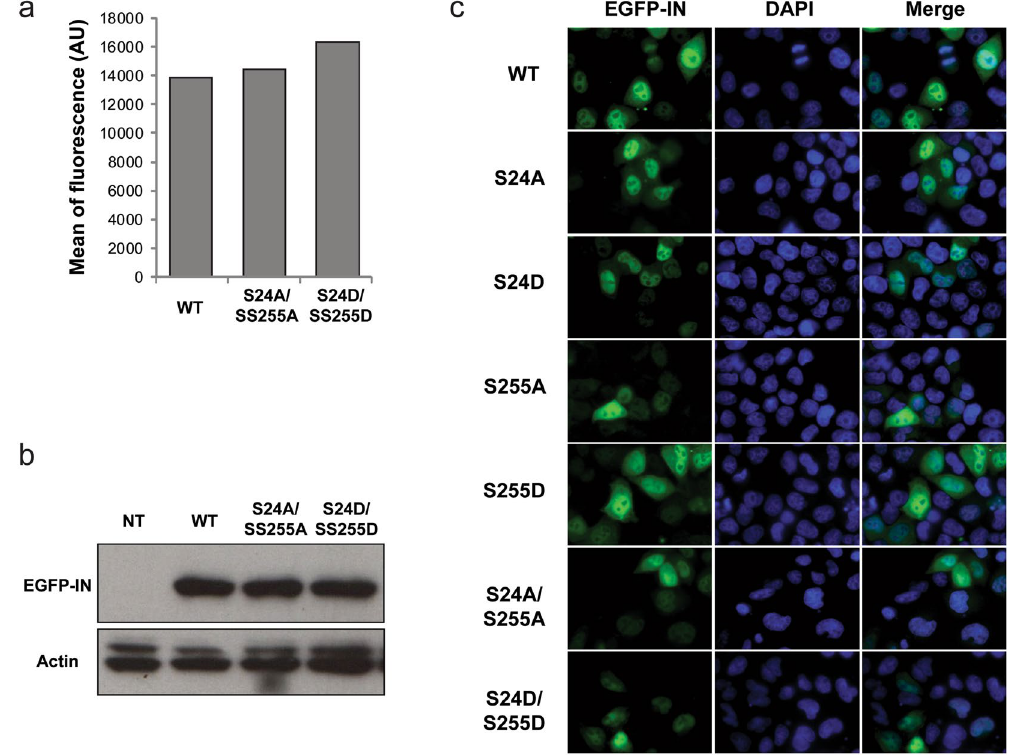
Figure 6. Effect of phosphorylation sites’ mutation on EGFP-IN expression in cells. 293 T transfected with a plasmid coding for WT or mutant EGFP-IN were analyzed by flow cytometry ( a ), western blot analysis ( b ) or microscopy ( c ). Lane 1: non transfected cells; lane 2: WT EGFP-IN; lane 3: S24A/S255A EGFP-IN; lane 4: S24D/ S255D EGFP-IN. For microscopy, nuclei were stained with